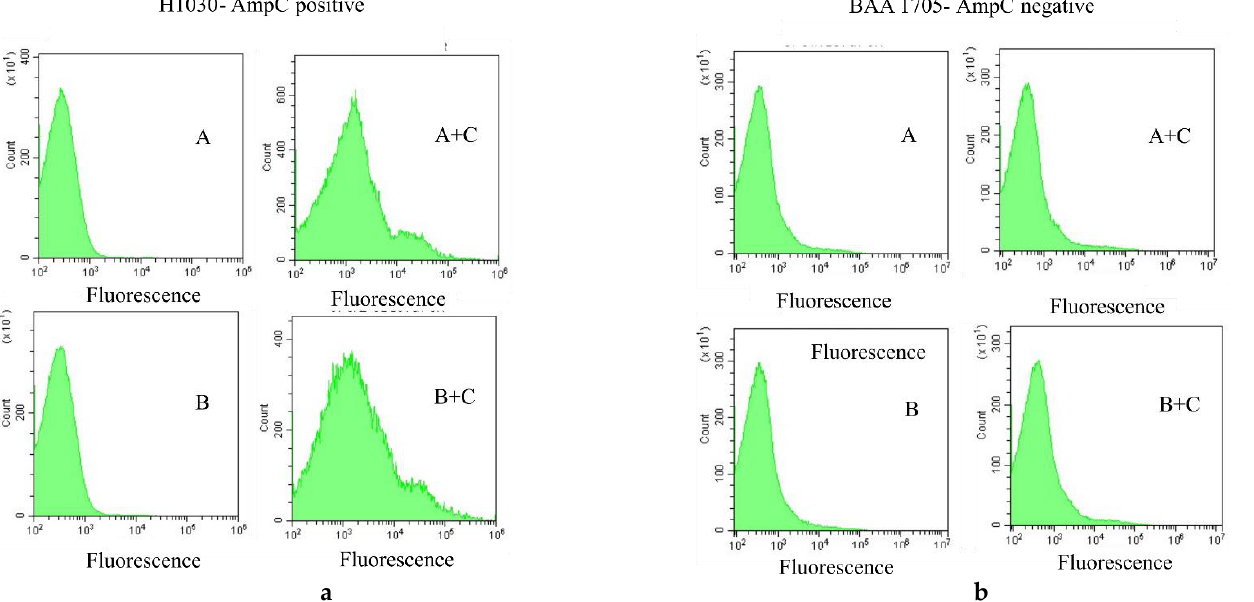
Figure 3. Histograms representing an example of one pAmpC-positive (H1030) and one pAmpC- negative (BAA 1705) strain. ( a ) Cells incubated for 1 h with cefotaxime; ( b ) Cells incubated for 1 h with ceftazidime; (A+C) and (B+C) Cells incubated with A or B associated with cloxacillin (C) for 1 h. An increase in the intensity of fluorescence (peak in the histogram shift to the right) is evident only on the pAmpC-positive strain when cloxacillin is associated with the cephalosporins.